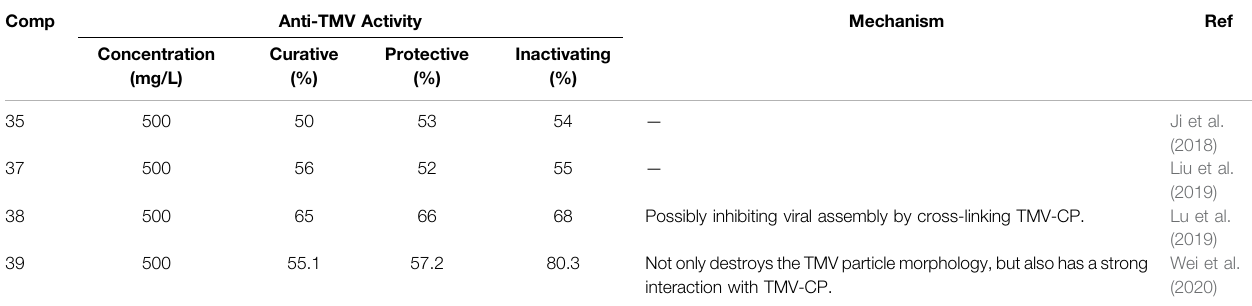
TABLE 1 | Antiviral activity of other representative indole